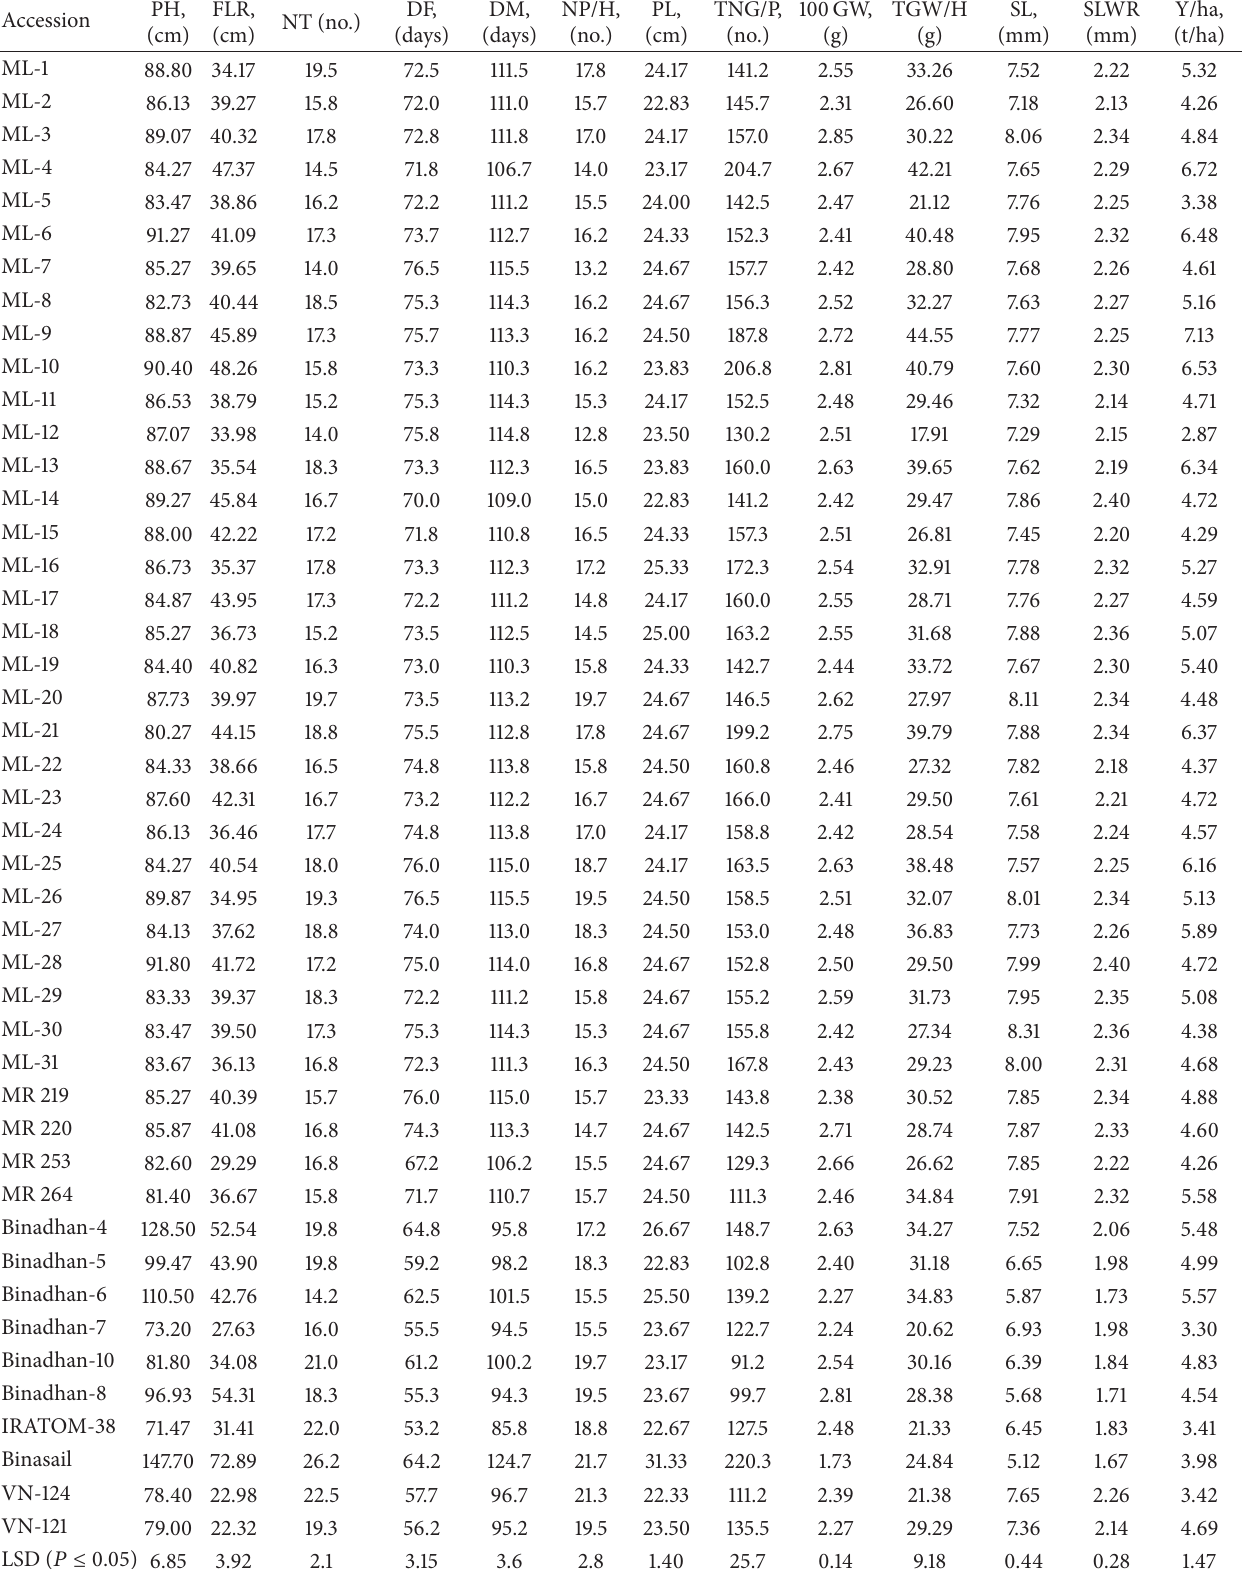
Table 3: Morphological traits, yield and yield components of rice accession for the two